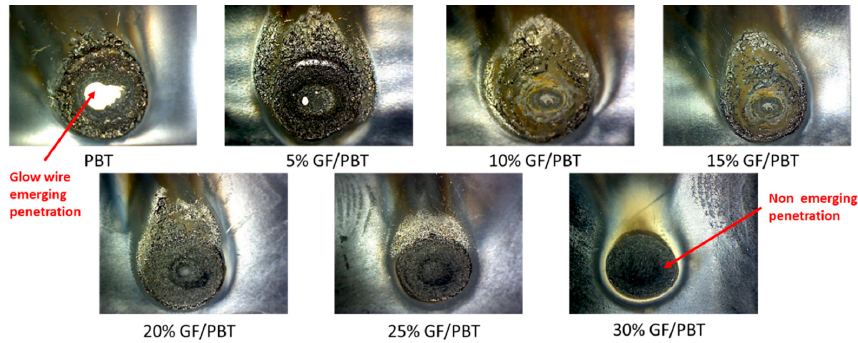
Figure 13. Appearance of the ignited surface vs. GF reinforcement rate.